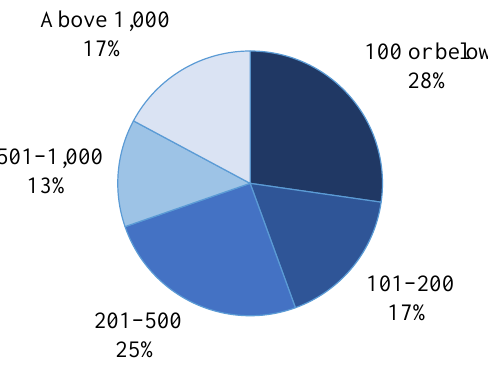
Figure 1. Proportion of the sample sizes of the